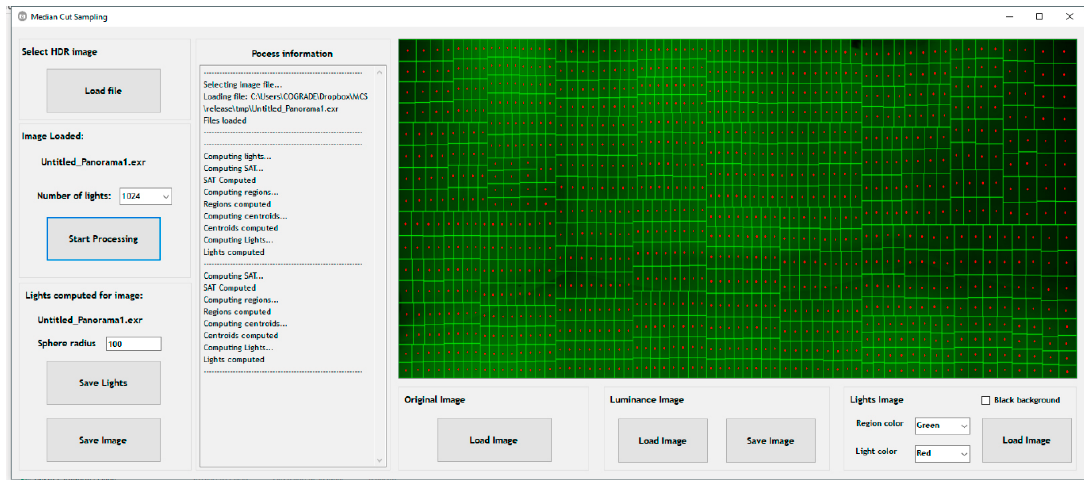
Figure 5. Cyclorama illumination analyzer user interface.